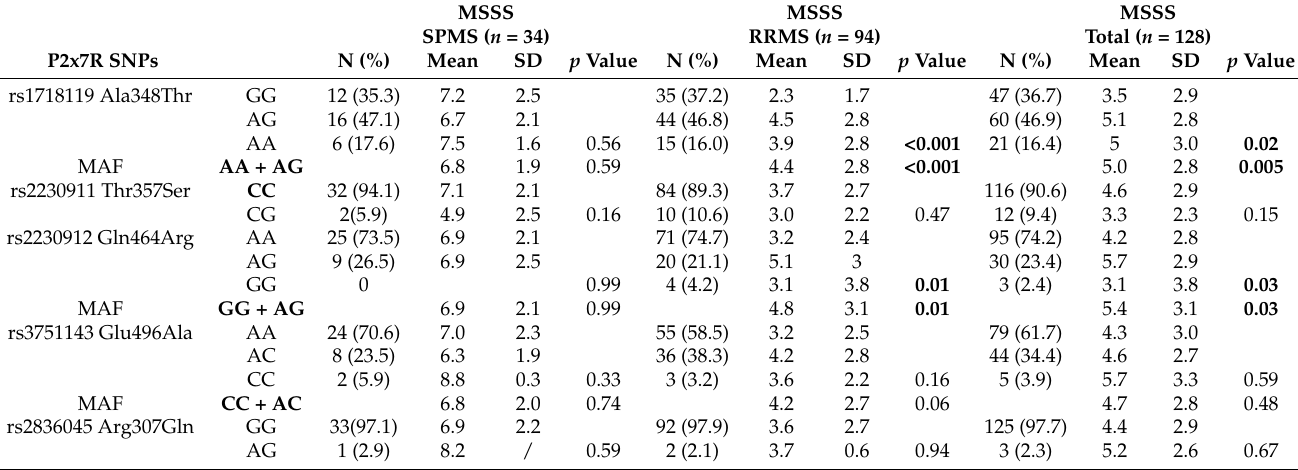
Table 2. P2X7R genotype distribution was reported in MS patients as N: absolute number and %: percentage, and multiple sclerosis severity score (MSSS) values were reported as mean and standard deviation (SD). ANOVA p value correlation analysis was reported between genotype, minor allele frequency (MAF) distribution, and MSSS values. Statistically significant associations are marked in